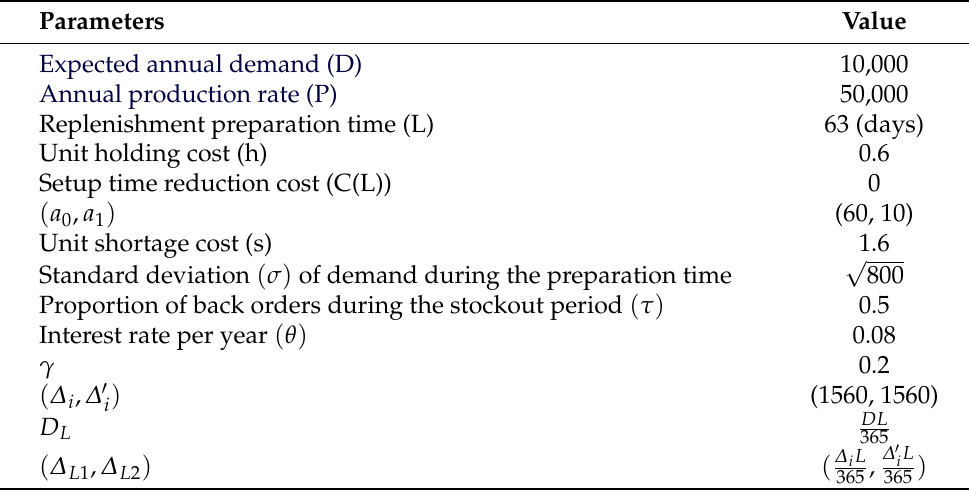
Table 3. Input parameters.